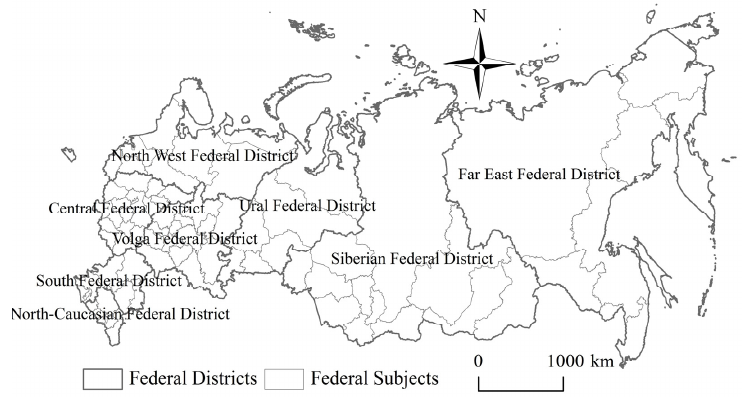
Figure 1. Sketch map of the study area.